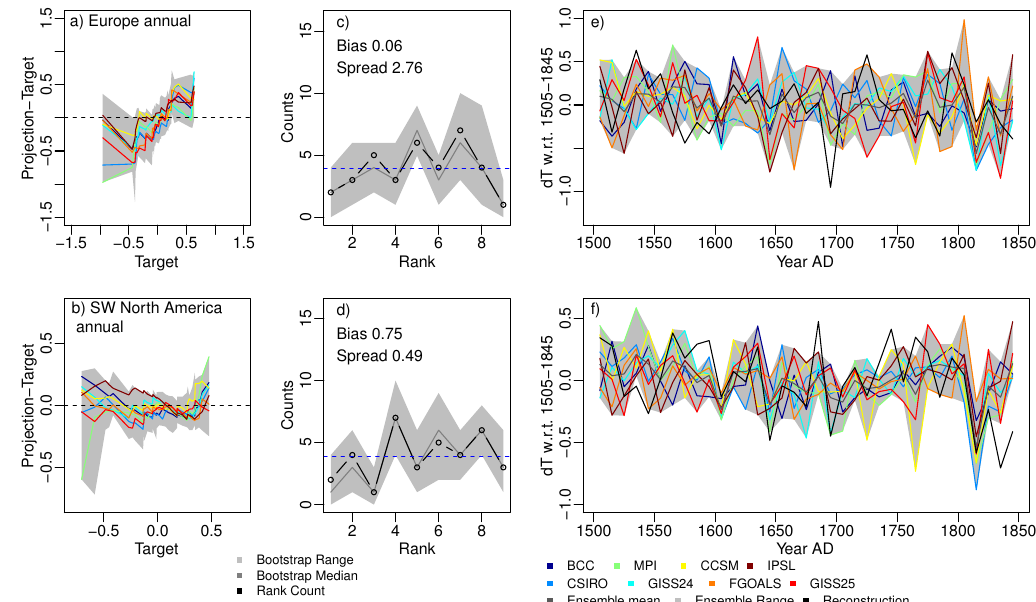
Fig. 6. Full-period residual quantile-quantile plots (left panels, in K), rank counts (middle panels) and time-series plots (right panels, in K) for the reconstructions by (top panels) Dobrovolný et al. (2010) of Central European annual temperature and (bottom panels) Wahl and Smerdon (2012) of North American Southwest annual temperature. For details on the representation, see the caption of Fig.